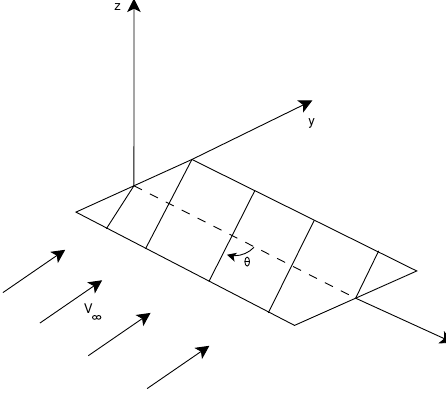
Figure 6. Plate wing fiber orientation